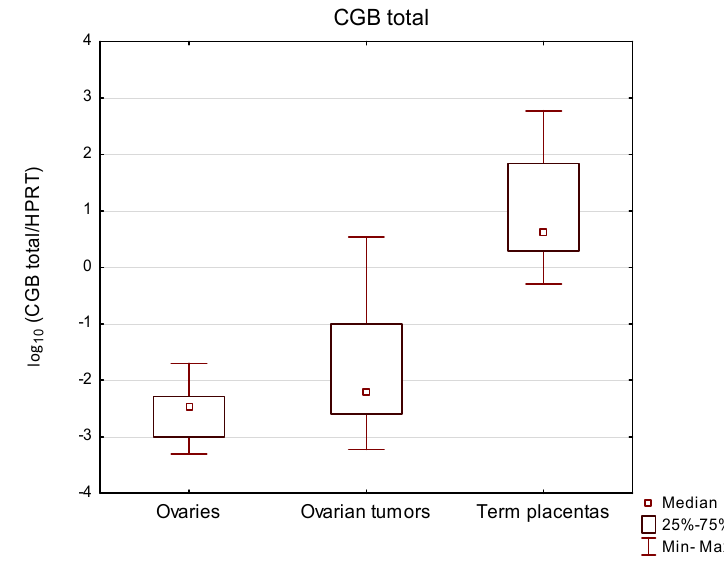
Figure 1. Relative expression of total CGB genes in normal ovarian tissues, ovarian carcinomas and term placentas. Results are presented as the logarithm to the base